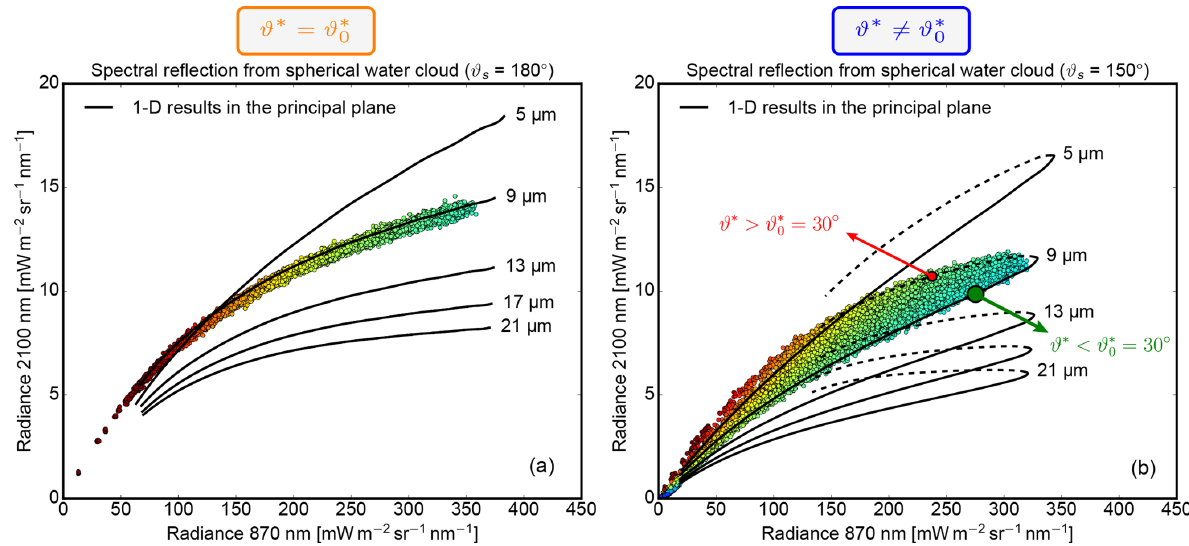
Figure 12. The scatterplots show the spectral radiances at λ = 870nm and λ = 2 . 1µm for the spherical cloud cases with a fixed r eff = 9µm. (a) Results from Fig. 11a for a fixed scattering angle of ϑ s = 180 ◦ and (b) from Fig. 11c for ϑ s = 150 ◦ . The color of the scatter points can be used to identify their location on the spherical water cloud in Fig. 11b and d. For the same scattering angles and analogous to Fig. 8, the black isolines show radiances from 1-D DISORT simulations for an optically thick water cloud ( τ c = 500) with different effective radii and variable cloud surface orientation. As previously, the green and red dots mark viewing configurations shown in Fig. 9.